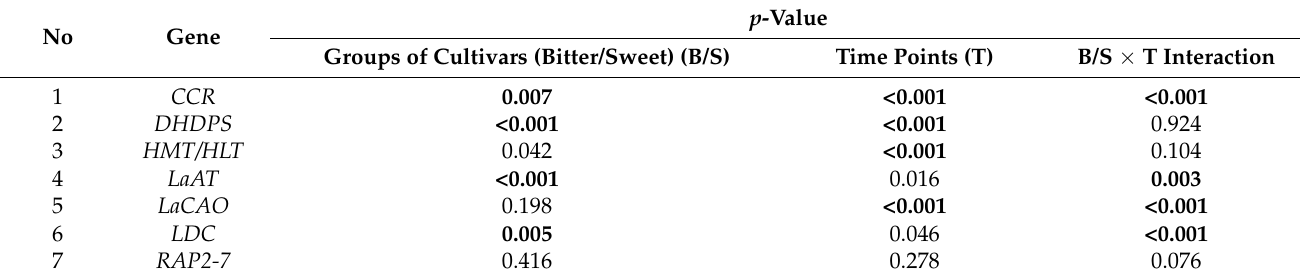
Table 7. Summary of ANOVA for two groups of narrow-leafed lupin cultivars with contrasting seed alkaloid content— plants with high alkaloid content are referred to as ‘bitter’ (two cultivars) and plants with low alkaloid content are referred to as ‘sweet’ (six cultivars). Expression was analyzed by qPCR assay. Effects were considered significant for p < 0.01 (marked in bold). Full names of genes are listed in Table